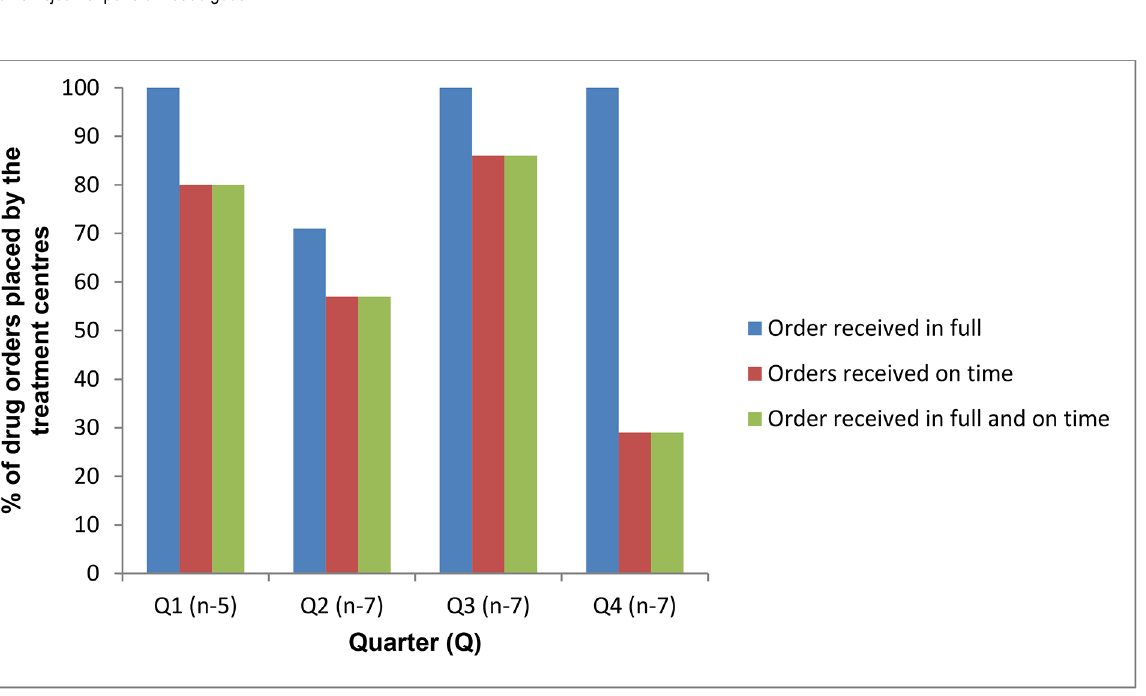
PLOS ONE | DOI:10.1371/journal.pone.0128500 June 22,